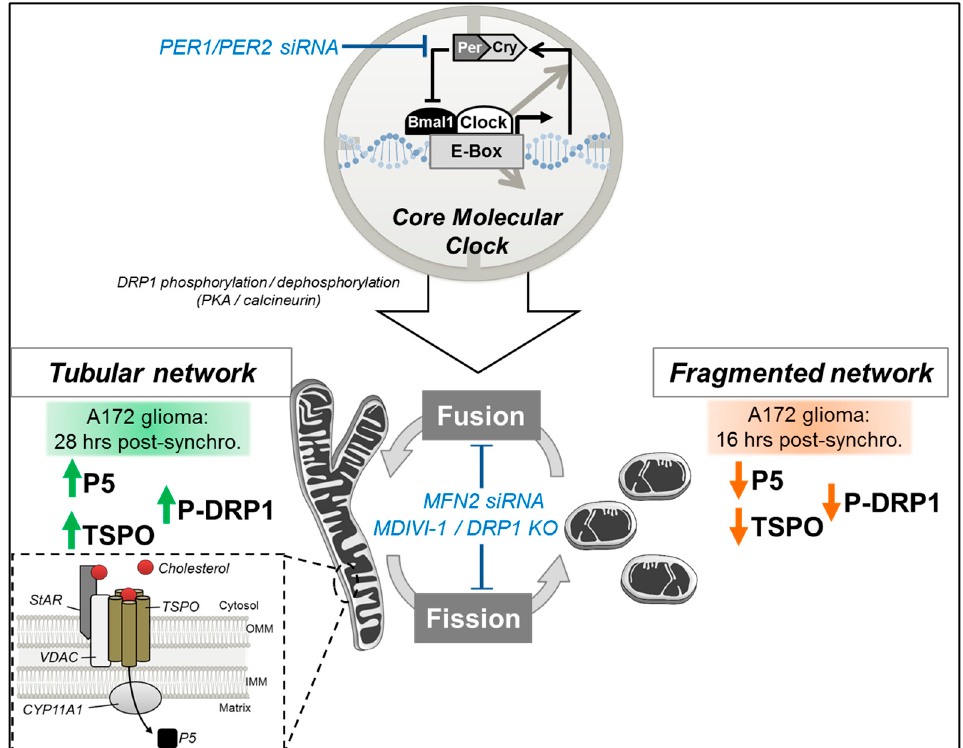
Figure 6. Schematic representation of the relationship between the core molecular clock, mitochondrial dynamics, and neurosteroid synthesis. The clock-controlled mitochondrial morphology correlate with mitochondrial neurosteroidogenesis, with high P5 and TSPO levels detected after fusion (increased P-DRP1 and mitochondrial elongation), and low P5 and TSPO levels after fission (decreased P-DRP1 and mitochondrial fragmentation). Circadian variations of P5 and TSPO are abolished when mitochondrial dynamics are disturbed (e.g., by MFN2 siRNA or MDIVI-1) or when the core molecular clock is affected (siRNA-mediated knockdown of PER1/PER2). CYP11A1: cytochrome P450 side-chain cleavage enzyme, IMM: inner mitochondrial membrane, OMM: outer mitochondrial membrane, MFN2: mitofusin 2, P5: pregnenolone, P-DRP1: dynamin-related protein 1 phosphorylated at serine 637, PER1/PER2: Period 1/2, TSPO: translocator protein, StAR: steroidogenic